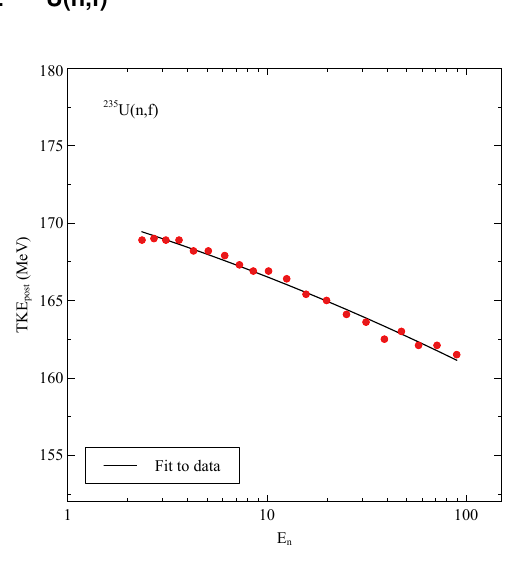
Figure 2. The average post-fission TKE measured for the 235 U(n,f) reaction as a function of neutron energy.